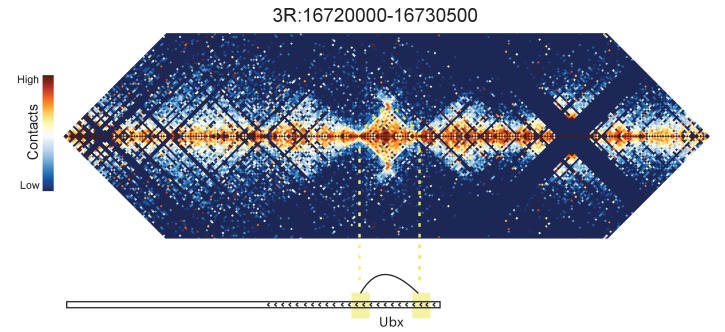
Hi-C map for the locus spanning 3R:16720000-16730500.A looping interaction is seen between two regions contained within the Ubx transcription unit.